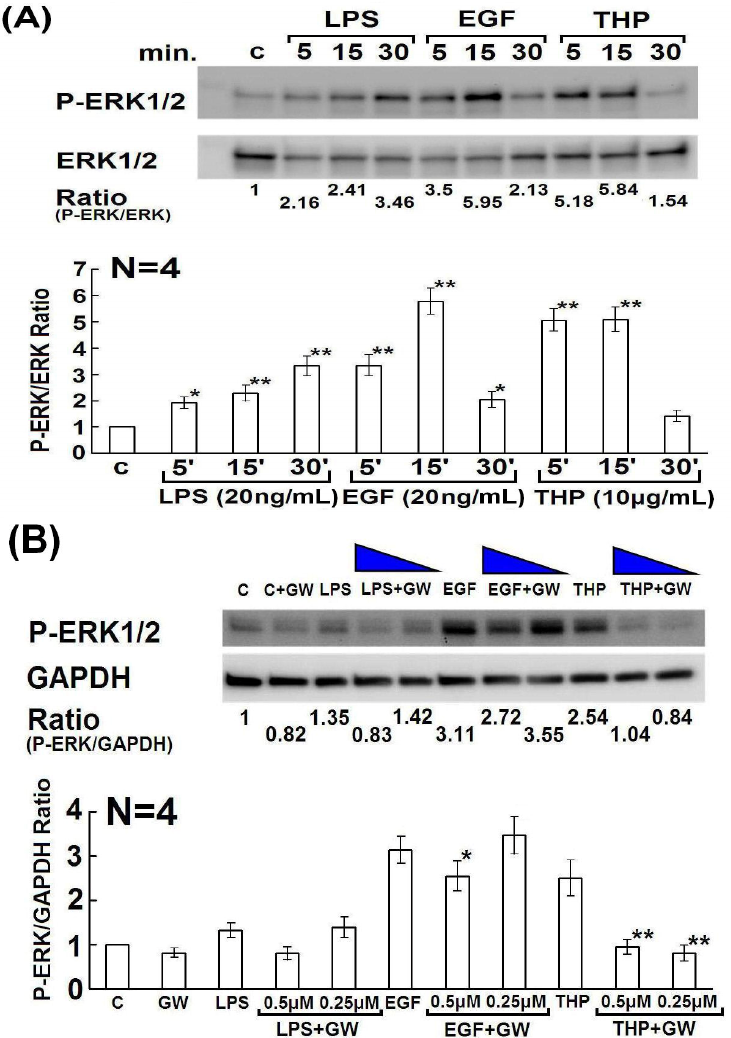
Figure 4. In panels ( A ) and ( B ), the upper panels are representative cases and lower panels show the statistical assessment. ( A ) Kinetic induction of phospho-ERK1/2 in HL-60 cells by LPS, EGF, and THP from 5 to 30 min. ( B ) Inhibitory effects of GW2974 (0.25 μ M and 0.5 μ M) on LPS-, EGF-, and THP-induced phospho-ERK1/2 in differentiated HL-60 cells. * denotes p ≤ 0.05 compared to EGF and ** denotes p ≤ 0.01 compared to